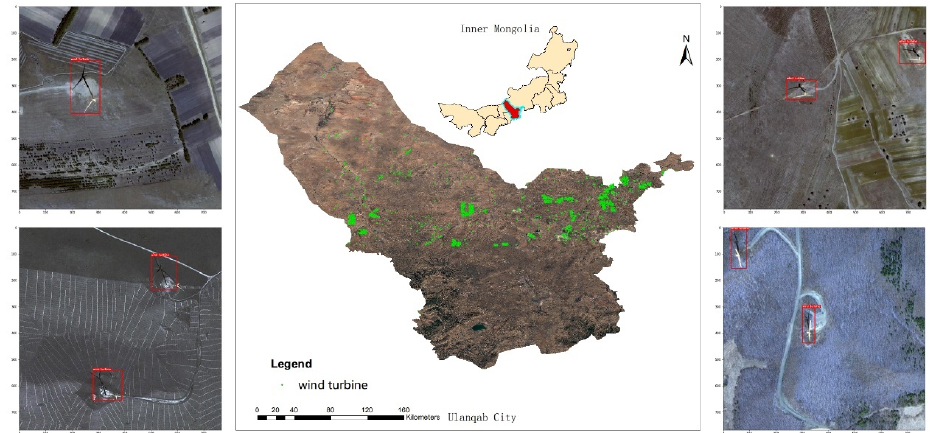
Figure 9. Wind turbine distribution in Inner Mongolia. The red box is the labelled bounding box for wind turbines, and the green points present the wind turbines’ locations on the